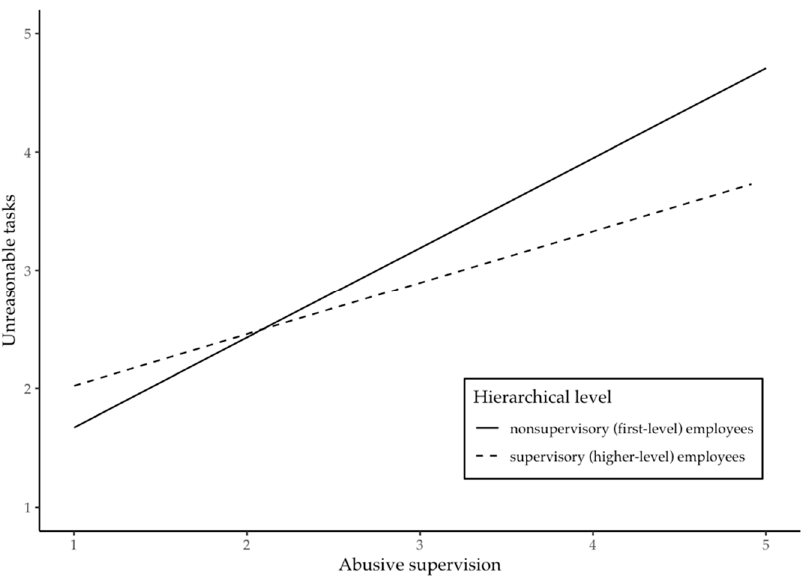
Figure 2. The moderating e ff ect of hierarchical level on the relationship between abusive supervision and unreasonable tasks.